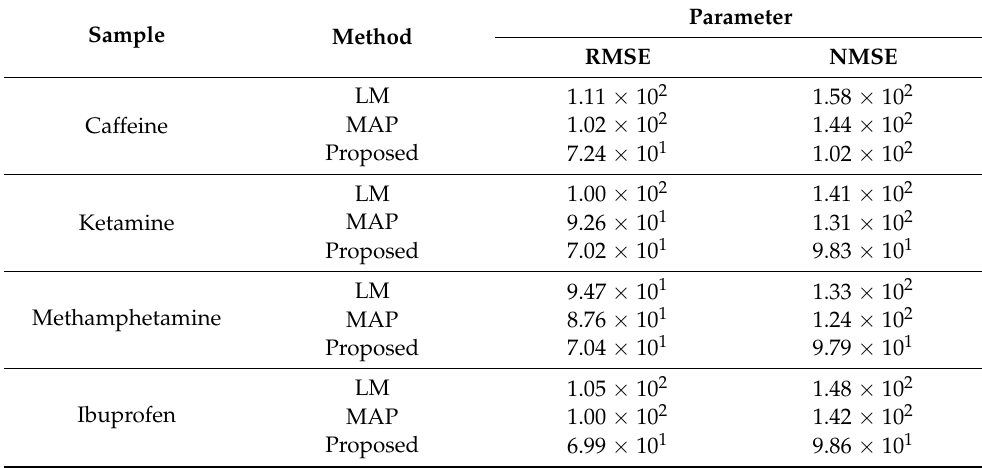
Table 4. RMSEs and NMSEs of the reconstruction results of different measured Raman spectra by four methods.